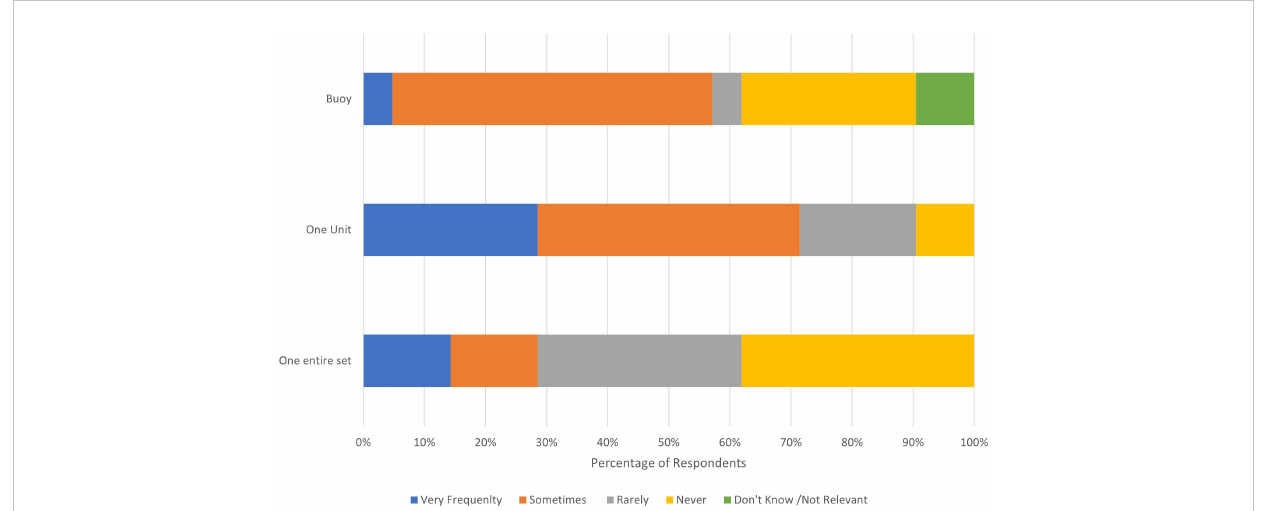
FIGURE 10 Summary of interview results from Dominica to the question: “ When or if fi sh traps or parts of traps are lost which of the following elements are lost and in what frequency? ” . (n =